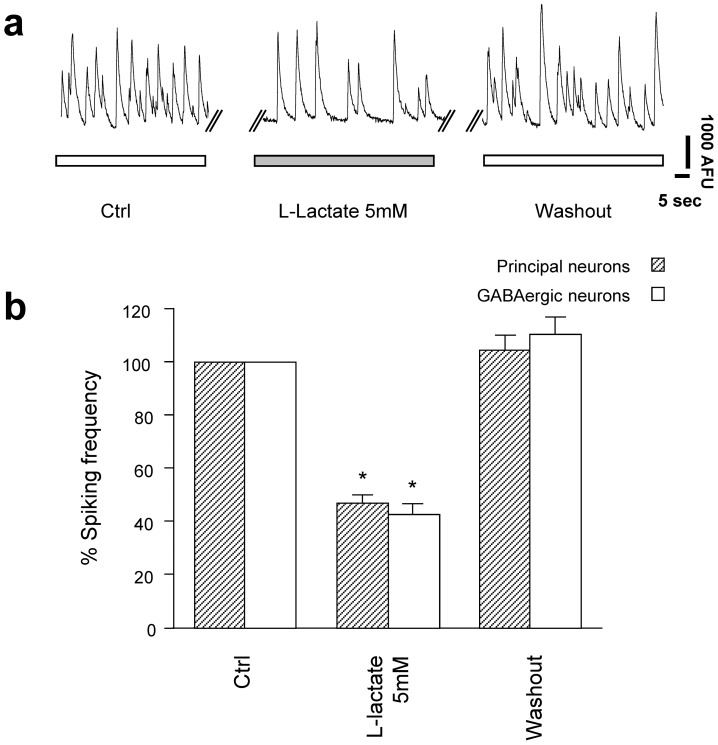
Effects of L-lactate on calcium spiking frequency.(a) Original traces of calcium transients in control or 5 mM L-lactate containing solution. (b) Calcium spiking frequency for principal glutamatergic neurons and GABAergic interneurons are shown as percent of activity measured during control solution. Data are obtained from 49 principal cells and 35 interneurons from 13 experiments.